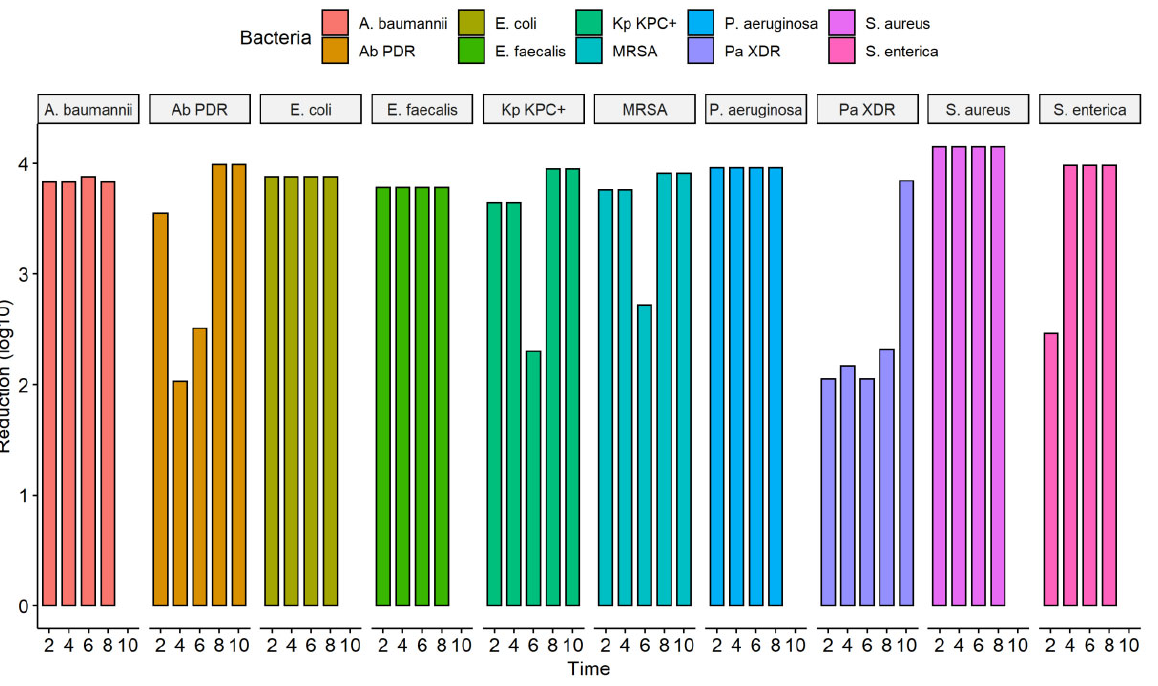
Figure 4. Quantifying the number of CFU/mL in the solid medium of the different bacterial strains ATCCs ( S. aureus (ATCC 6538), P. aeruginosa (ATCC 15442), S. enterica (ATCC 10708), E. coli (ATCC 25922), A baumannii (ATCC 19606), and E. faecalis (ATCC 29212) and MDR strains representative of the ESKAPE ‐ E group S. aureus (MRSA), P. aeruginosa (XDR), A. baumannii (PDR) and K. pneumoniae (KPC+)). In addition, the number of CFU/mL was quantified in the bacterial suspensions (10 4 CFU/mL) after exposure to the UV ‐ C system for 2, 4, 6, 8, and 10 s and in the control group (no treatment). Boxes represent median and lines standard deviations.